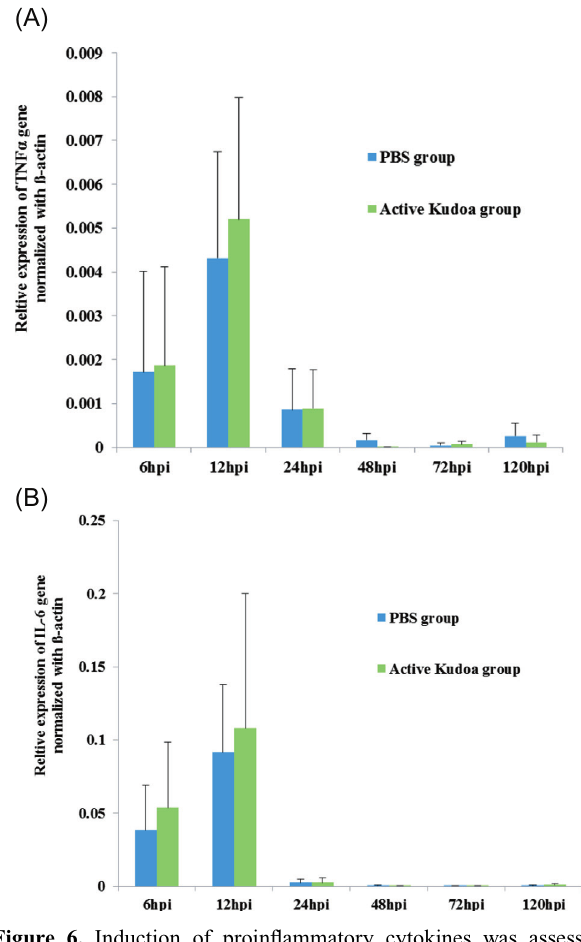
Figure 6. Induction of proinflammatory cytokines was assessed using the administration of phosphate-buffered saline or K. septempunctata at 5 · 10 6 spores/mouse in suckling mice. Tumour necrosis factor (TNF a ) (Fig. 6A) and interleukin 6 (IL-6) (Fig. 6B) expression levels were examined by SYBR green quantitative polymerase chain reaction and normalised using b -actin expression as an internal control. Relative levels of immune gene mRNAwere analysed by the 2 (cid:2) D Ct method (the C t value of the target immune gene minus the C t value of the b -actin gene). Data are presented as means ± standard deviation. Hpi: hours